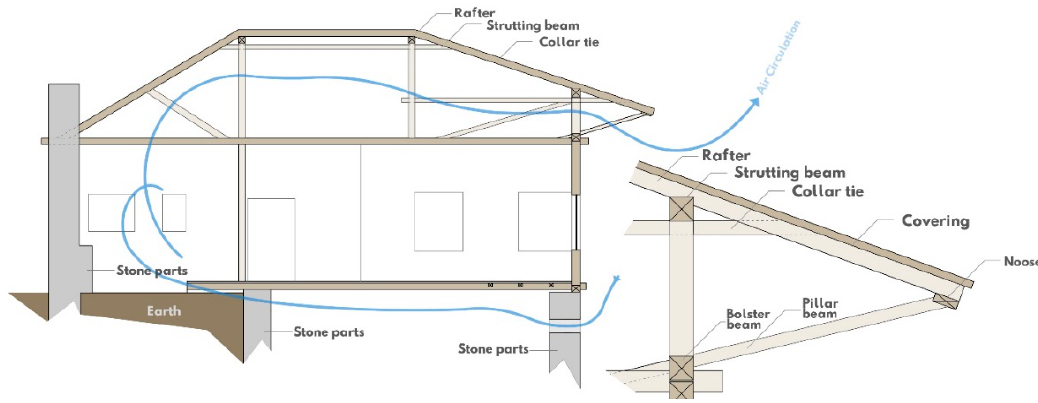
Figure 11. Air circulation and natural ventilation detail (re-illustrated from Ş en (1967)).